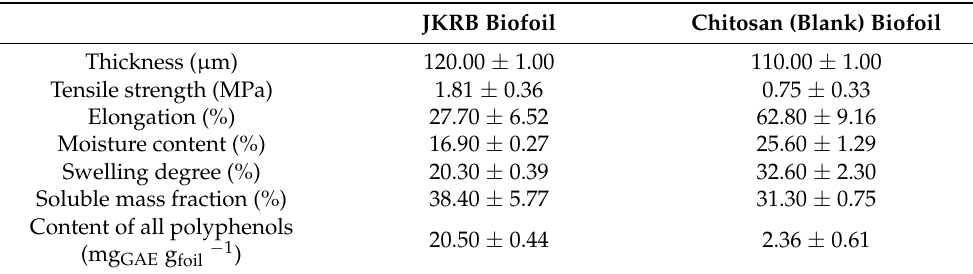
Table 4. Modified physicochemical properties of the JKRB biofoil in comparison to the chitosan (blank) biofoil.